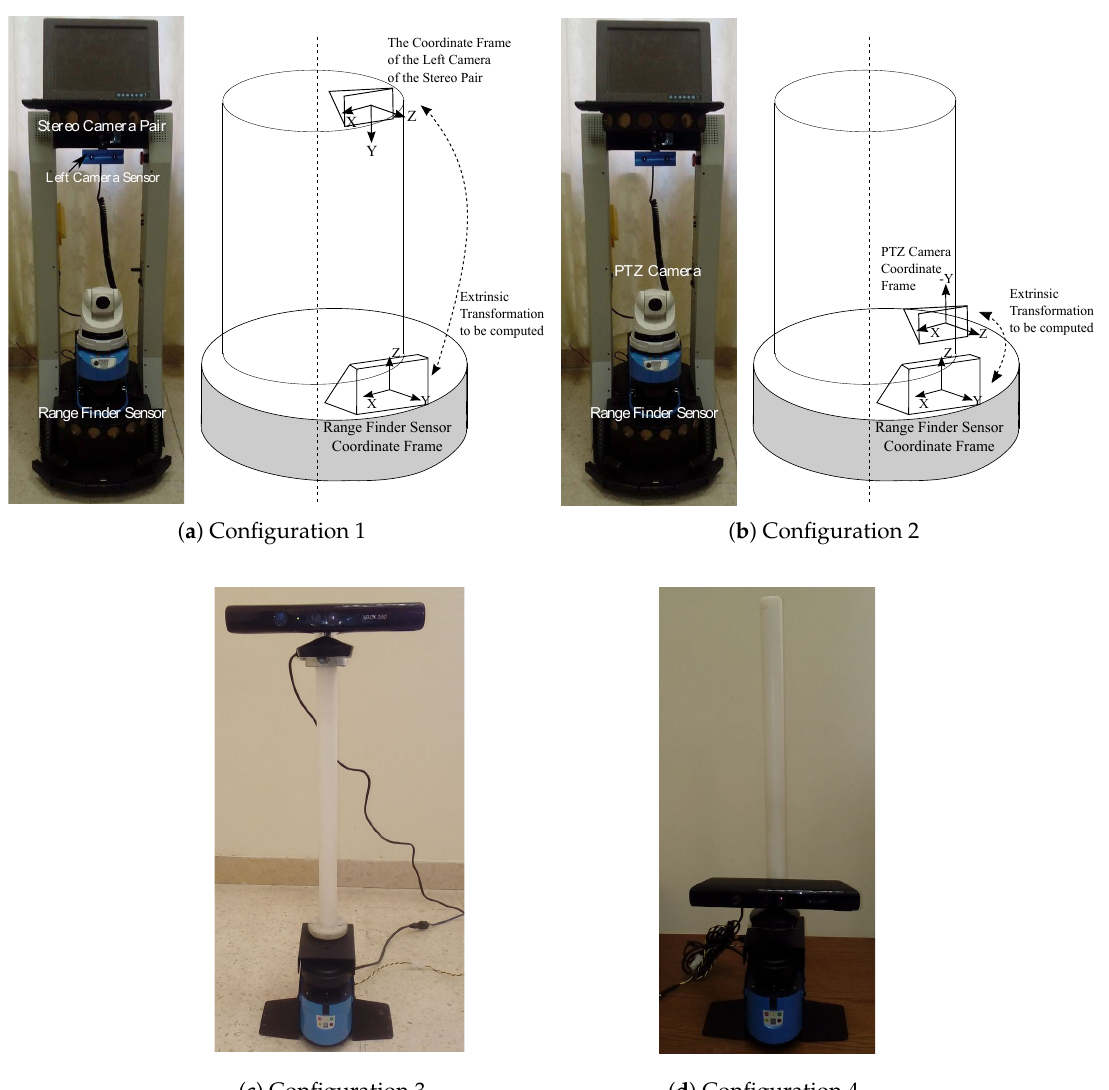
Figure 2. Four configurations of lidar–camera sensors: ( a ) SICK LMS-500 2D lidar (Minneapolis, MN, USA) and a mobileRanger C3D stereo camera (Focus Robotics, Hudson, NH, USA) rigidly attached to a PeopleBot robotic platform; ( b ) SICK LMS-500 2D lidar and AXIS 214 PTZ network camera (Axis Communications, Lund, Sweden) rigidly attached to a PeopleBot robotic platform; ( c ) SICK LMS-100 2D lidar and a Kinect Xbox 360 camera rigidly attached at a height similar to a mobile robot; ( d ) same configuration as of ( c ), but the camera is mounted at a shorter vertical distance from the